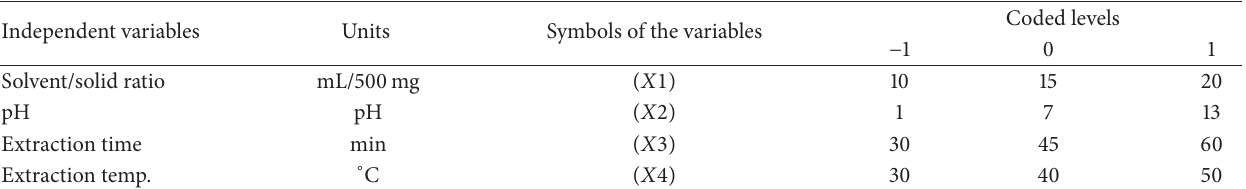
Table 3: Box-Behnken design of the independent variables ( 𝑋1 , 𝑋2 , 𝑋3 , 𝑋4 ) and experimental results for the EY.